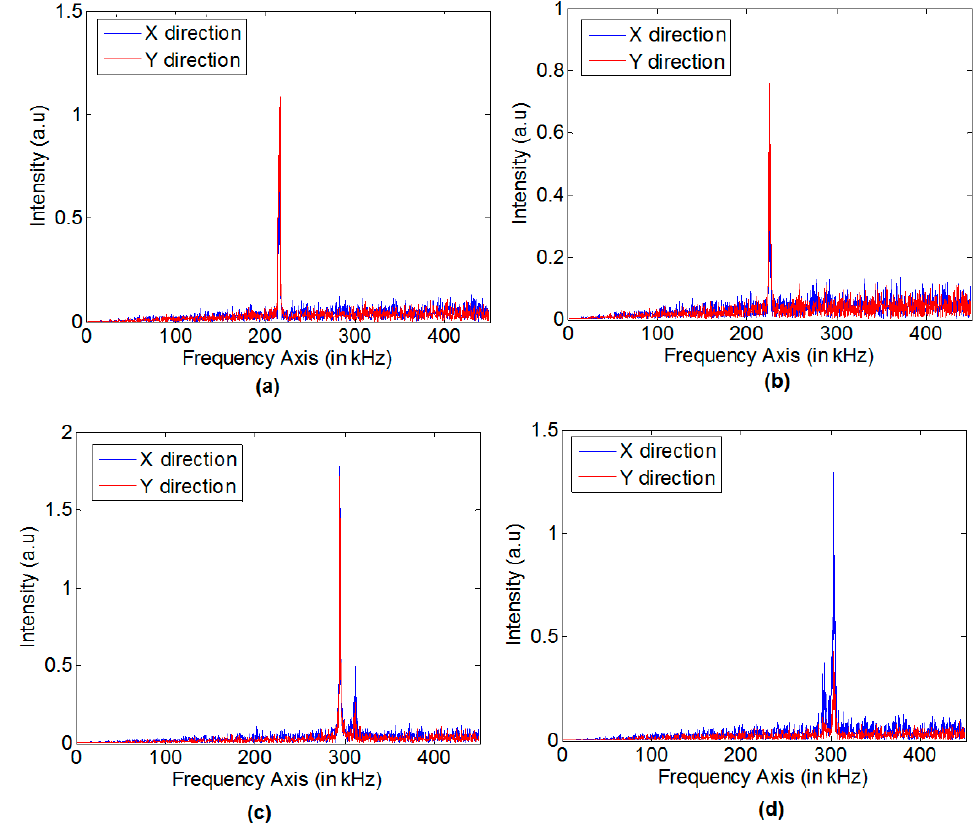
Figure 4. Experimental Results: The oscillation frequencies of the speckle pattern in horizontal (X direction) and vertical (Y direction) axes with pump, with different frequencies of modulation: ( a ) modulation frequency of 5.3001 GHz; ( b ) modulation frequency of 5.3003 GHz; ( c ) Modulation frequency of 5.3005 GHz; and ( d ) modulation frequency of 5.3007 GHz.